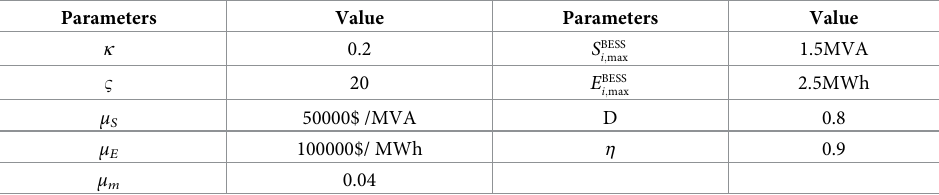
Table 2. Parameters of